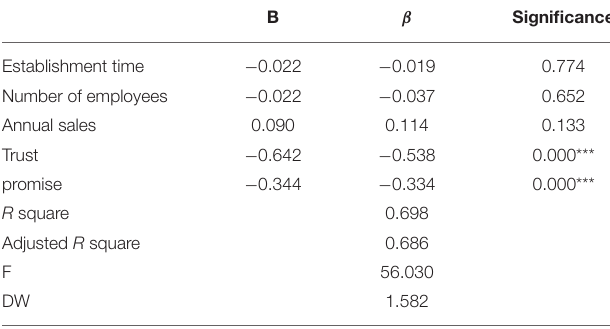
TABLE 3 | Regression analysis results of relationship quality and opportunistic